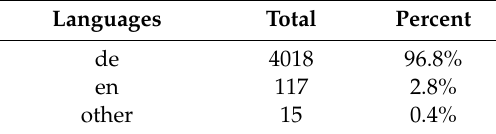
Table A21. Primary languages (de).